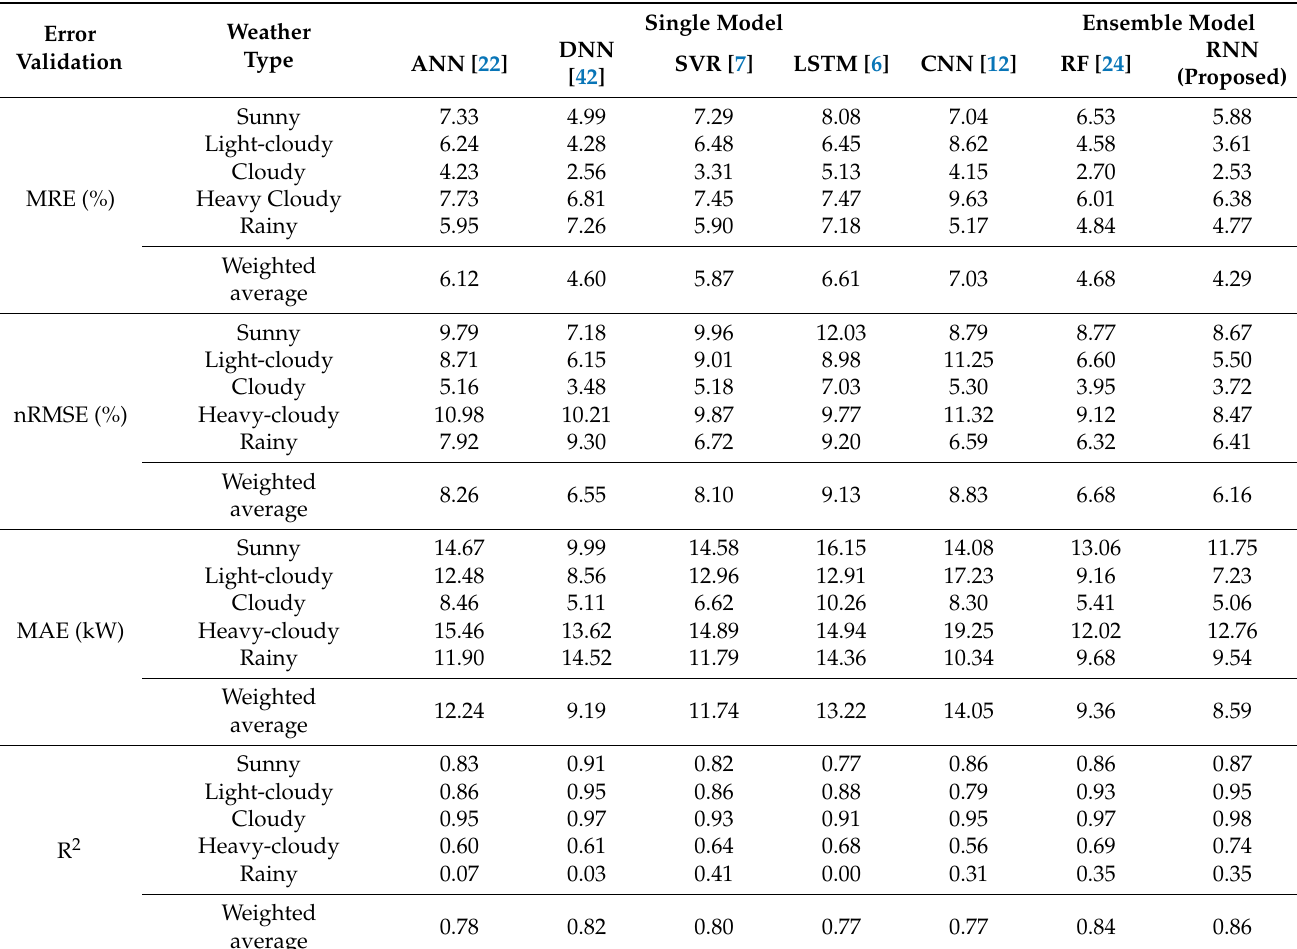
Table 7. Three-day ahead hourly forecasting